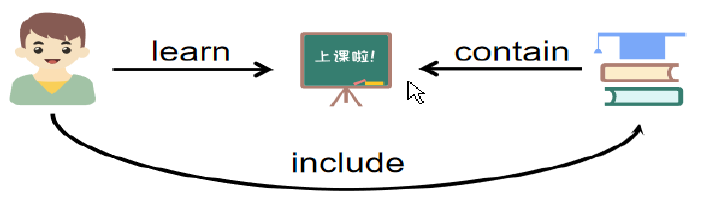
Figure 2. Network schema of HIN in